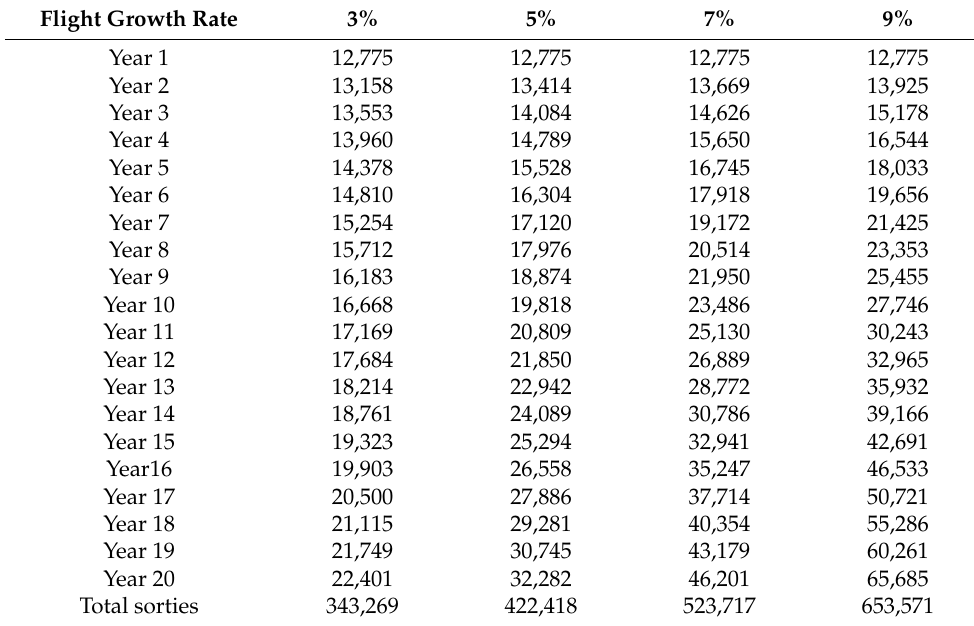
Table 6. Operation sorties in 1–20 years at different growth rates.